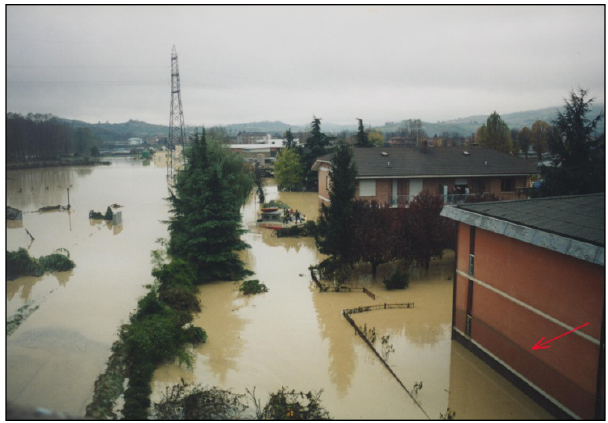
Fig. 3 – November 6, 1994, 1:00 p.m. The Tanaro River is still swollen. The effects of the flooding are evident. In the foreground, the link road of the Asti-Cuneo highway has been stripped by the violence of the waters. On the left, along the highway embankment, is the site where the deepest floodwaters (5.60 m) were measured (X in Fig. 2). In the background is a thick poplar forest recently planted in a natural area along the Tanaro. the Tanaro valley bottom between the confluence of the Tal- loria and Cherasca streams was flooded by a single expanse of water 2.5 km in width, on average.